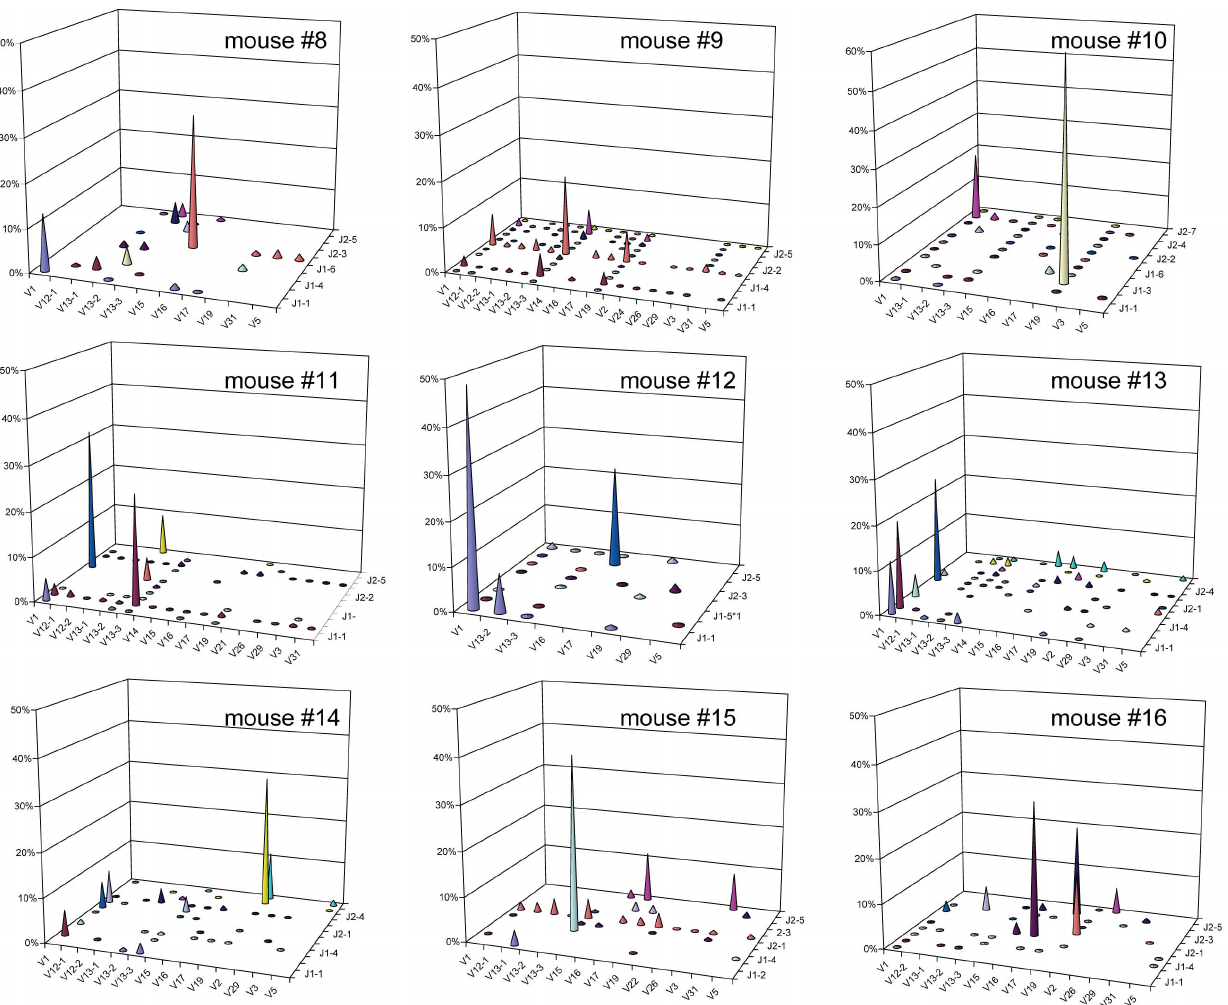
Figure 6. High-throughput sequencing analysis reveals monoclonal expansions in islet-infiltrating CD4 + CD44 high cells from diabetic mice. The frequencies of V and J gene segment usage within total CDR3 b sequences amplified from islet-infiltrating CD4 + CD44 high cells isolated from individual diabetic. Each panel represents one mouse.